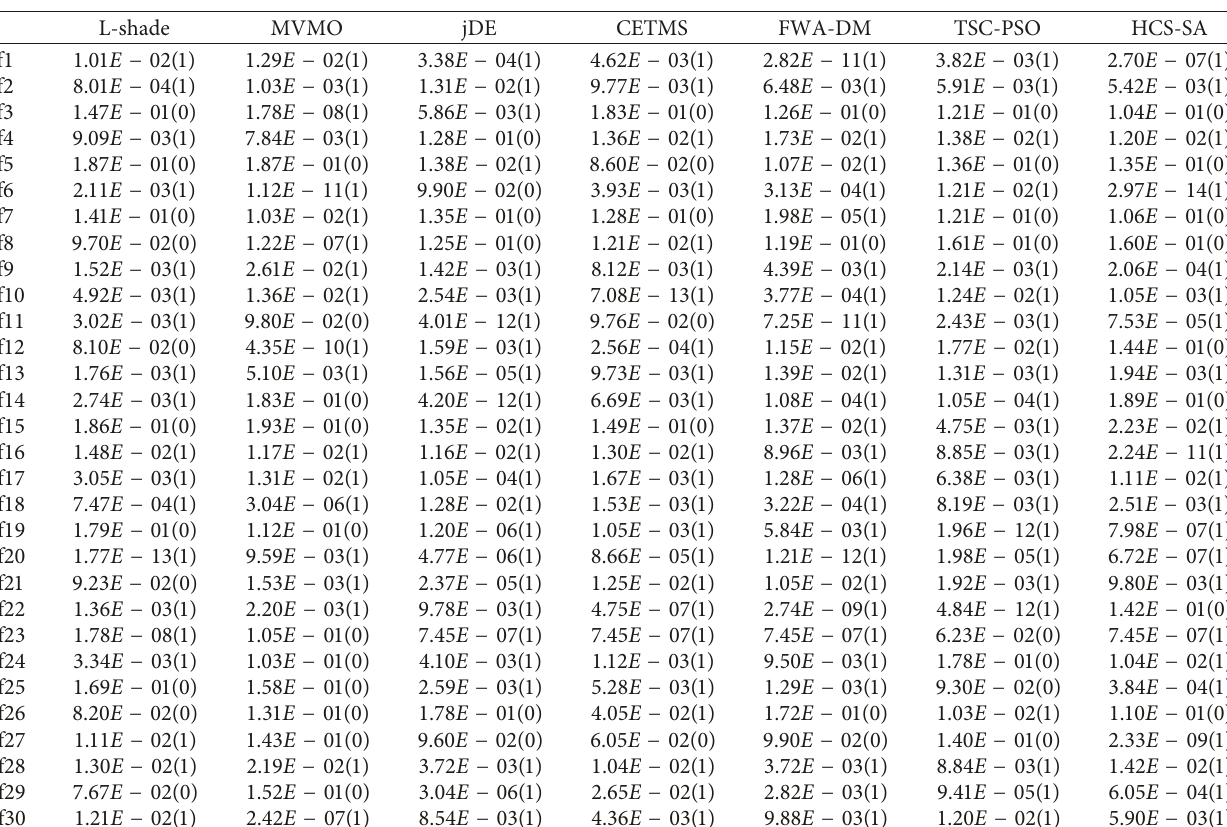
Table 18: Wilcoxon test against L-SHADE [36], MVMO [37], jDE [39], CETMS [40], FWA-DM [41], TSC-PSO [42], and HCA-SA [43]